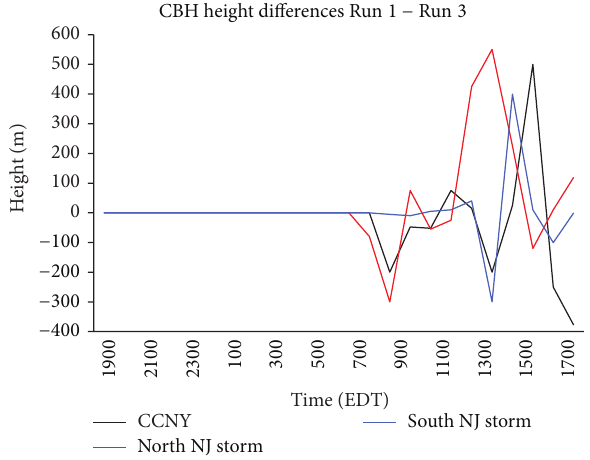
Figure 16: CBH differences between Run 1 and Run 3 for three different sites.